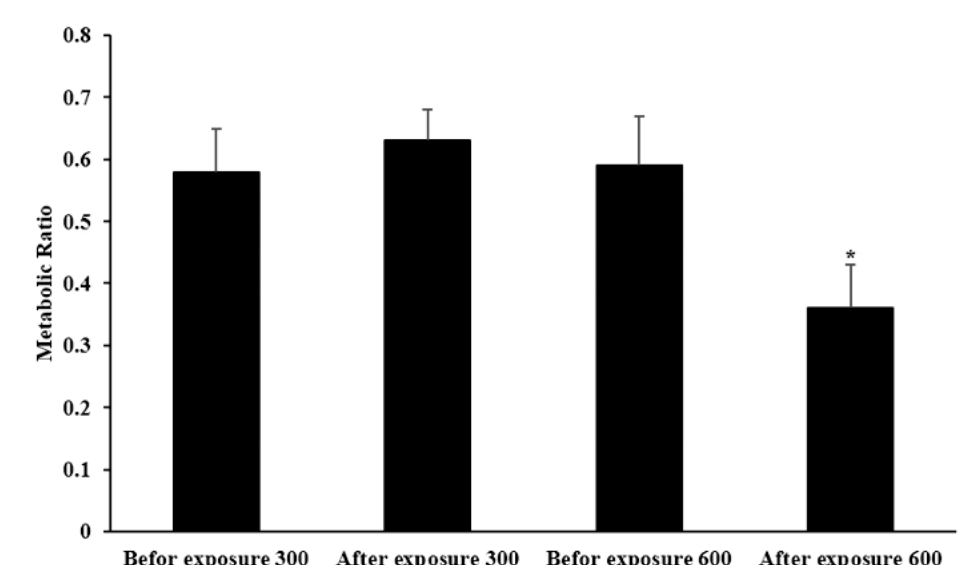
FIGURE 2 - Perfusate mean metabolic ratio profile (3 end-points), before and after exposure of rats’ liver to 300 ng/ml and 600 ng/ml of MDMA (Ecstasy), following the passage of the perfusion buffer containing 2000 μM chlorzoxazone through the portal vein (n= 12, mean ± SEM). Each experiment was repeated independently three times in triplicate tests and data are shown as mean ± SEM. *P≤